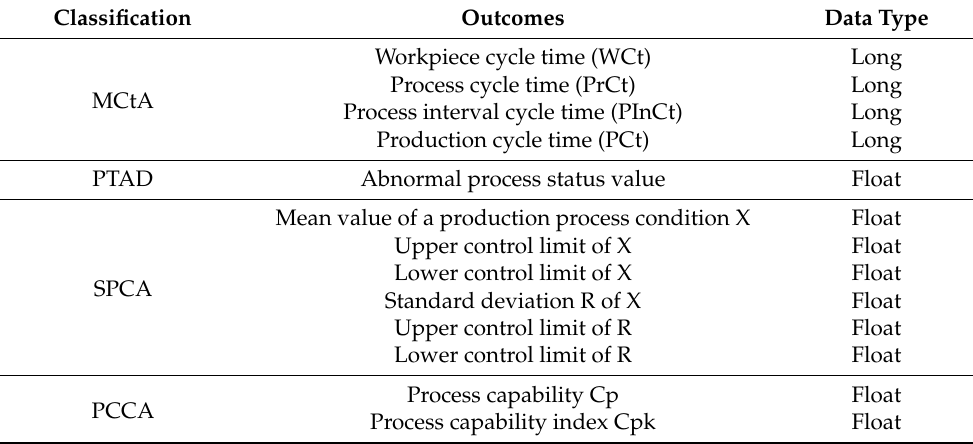
Table 3. Outcomes of composite statistical